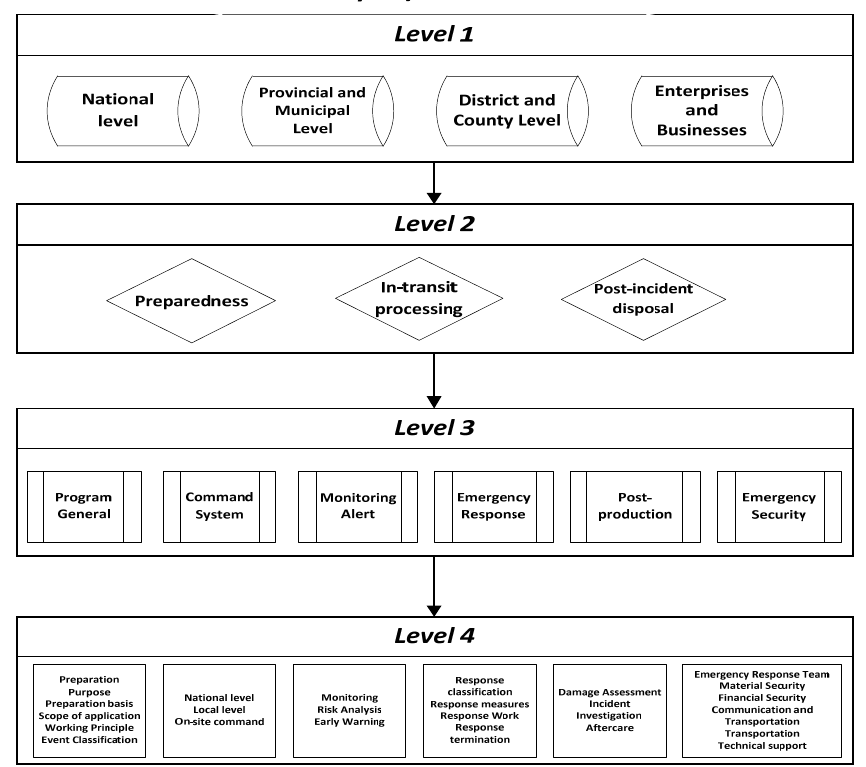
Figure 3. Pre-plan structure classification table.